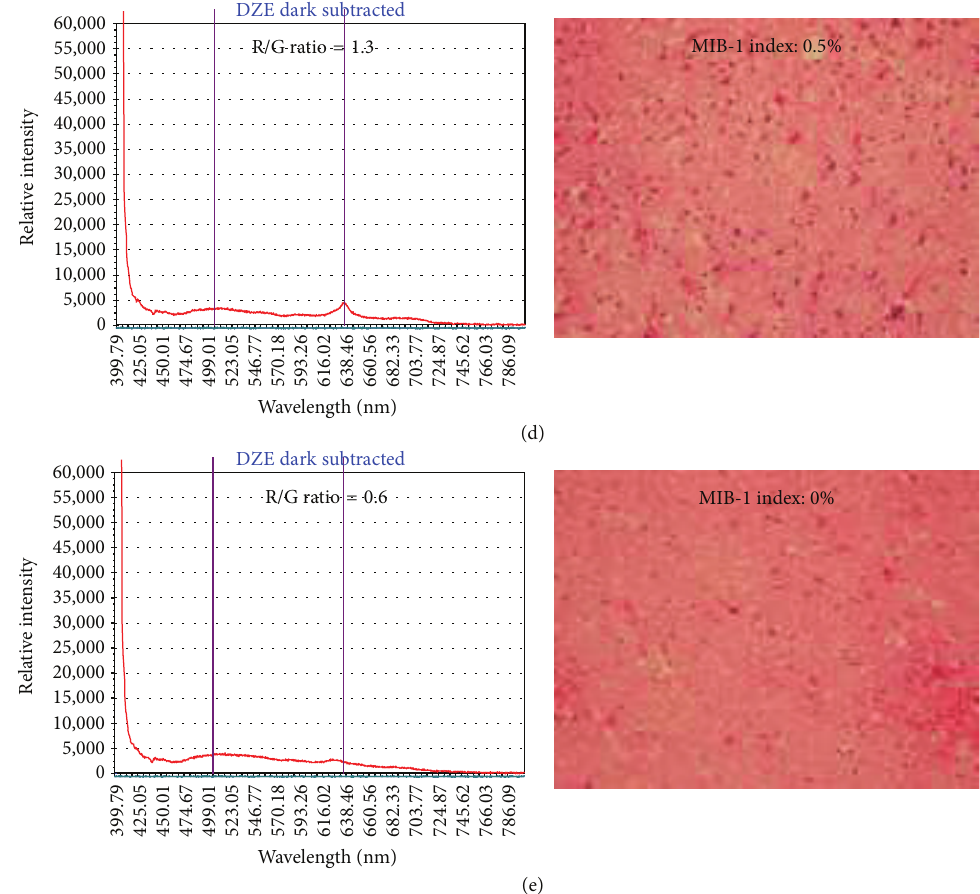
Figure 7: The analysis of the fluorescence spectrum and the histology in each lesion. Lesion (a) was central necrosis without macroscopic fluorescence. Lesion (b) showed the highest fluorescence macroscopically. Lesion (c) showed a faint fluorescence macroscopically. Lesion (d), adjacent to lesion (c), did not show macroscopic fluorescence. Lesion (e) did not show any fluorescence. The left panel shows the analysis of the fluorescence spectrum, and the right panel shows the histological examinations and MIB-1